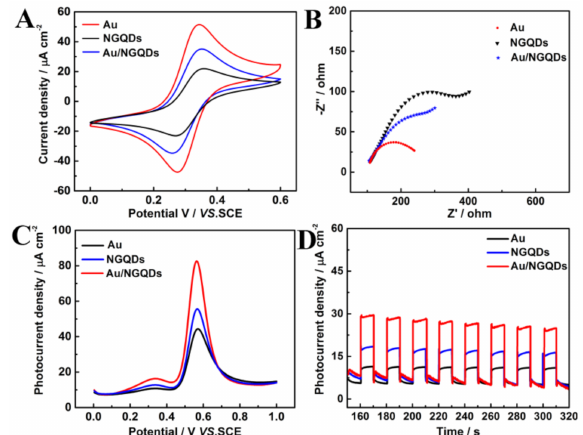
Figure 3. ( A ) The Cyclic voltammetry curve (CVs) and ( B ) Impedance measurement (EIS) spectra of Au, NGQD, and Au / NGQDs electrodes in 1.0 mM K 3 [Fe(CN) 6 ] / K 4 [Fe(CN) 6 ] containing 0.1 M KCl. ( C ) Di ff erential pulse voltammetry (DPVs) and ( D ) Time-current (i-t) responses of Au,